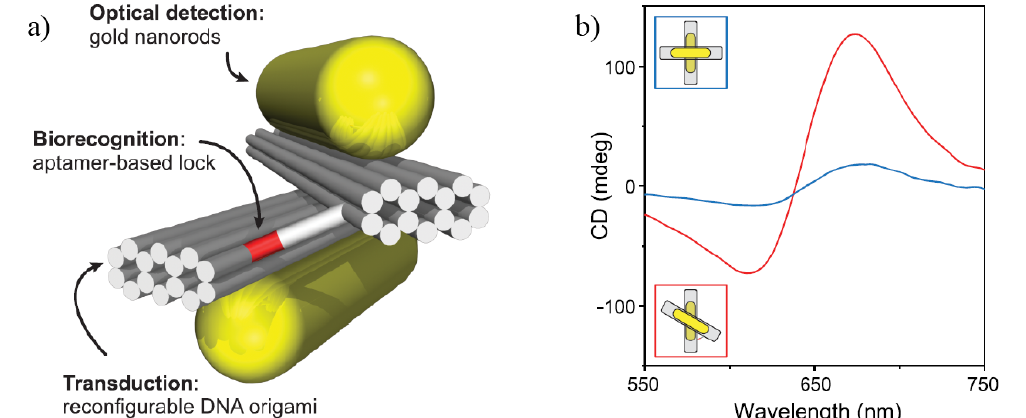
Figure 5. ( a ) A DNA-origami system with a bilayer composed of Au nanorods attached to aptamers (biorecognition elements). ( b ) CD spectra in orthogonal (blue line) and non-orthogonal (red line) configurations are presented. Reproduced with permission from ref. [72]. Copyright 2018 American Chemical